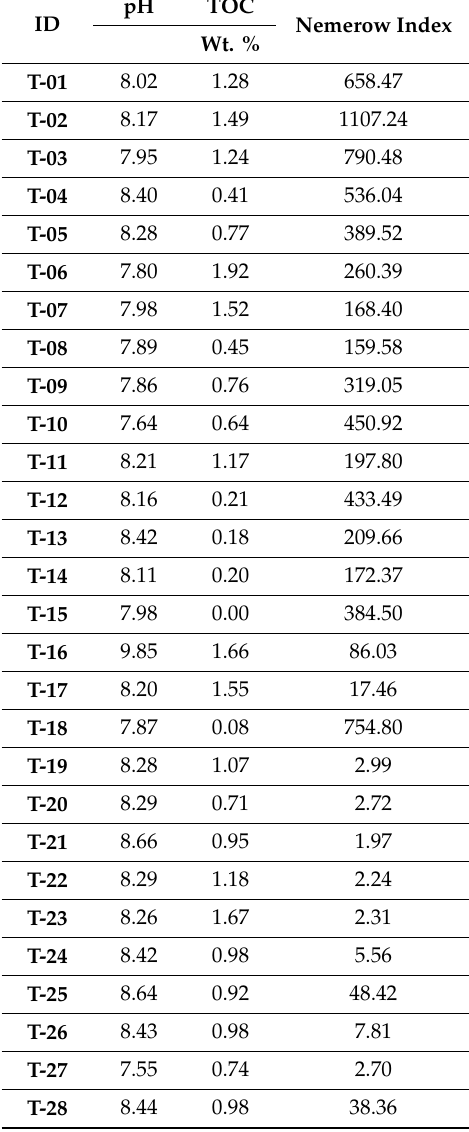
Table 1. The pH values, TOC values, and Nemerow index of the 28 samples. pH TOC ID Nemerow Index Wt.